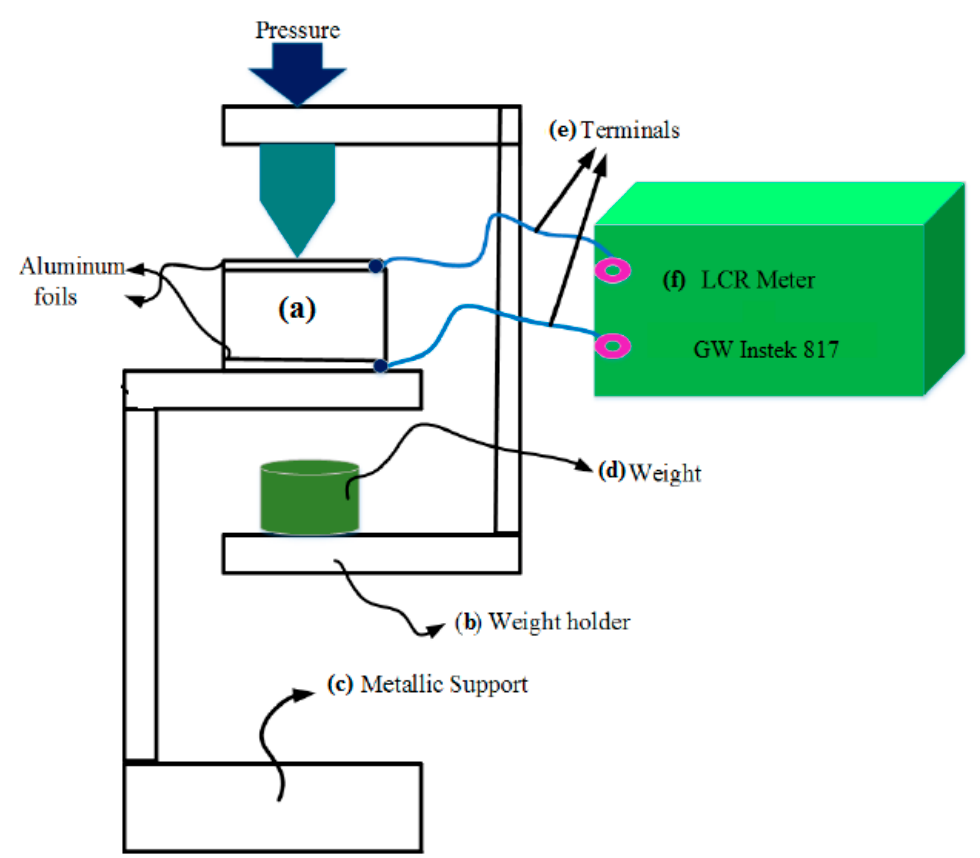
Figure 4. Corresponding schematics diagram of Figure 3.